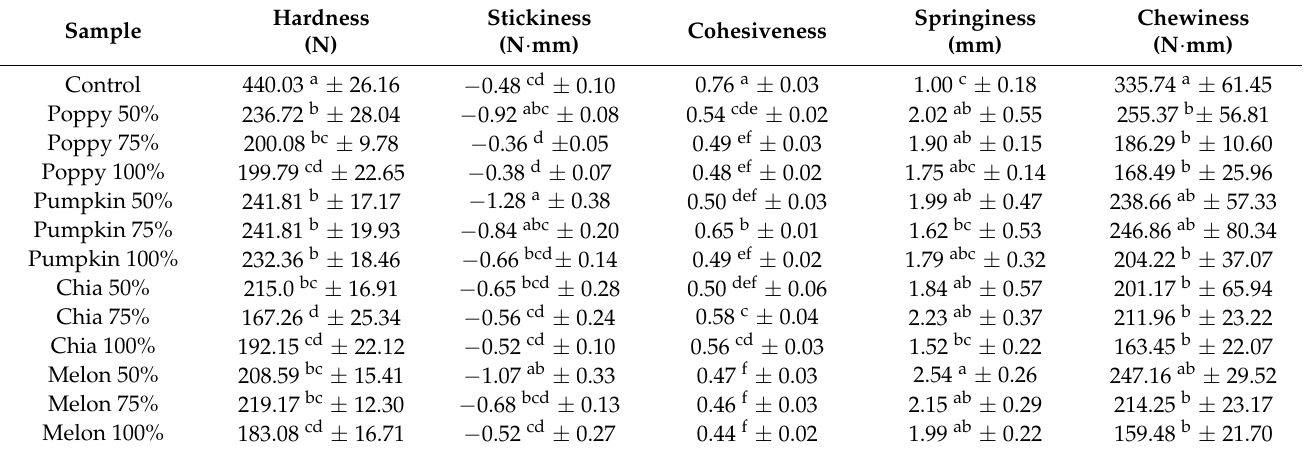
Table 1. Results obtained for the texture parameters of the fuet samples prepared with different emulsified seed oils.